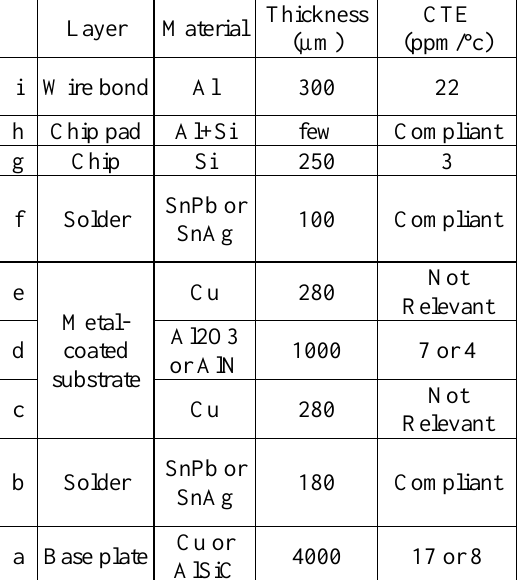
Table 1: Materials used in IGBT module structure